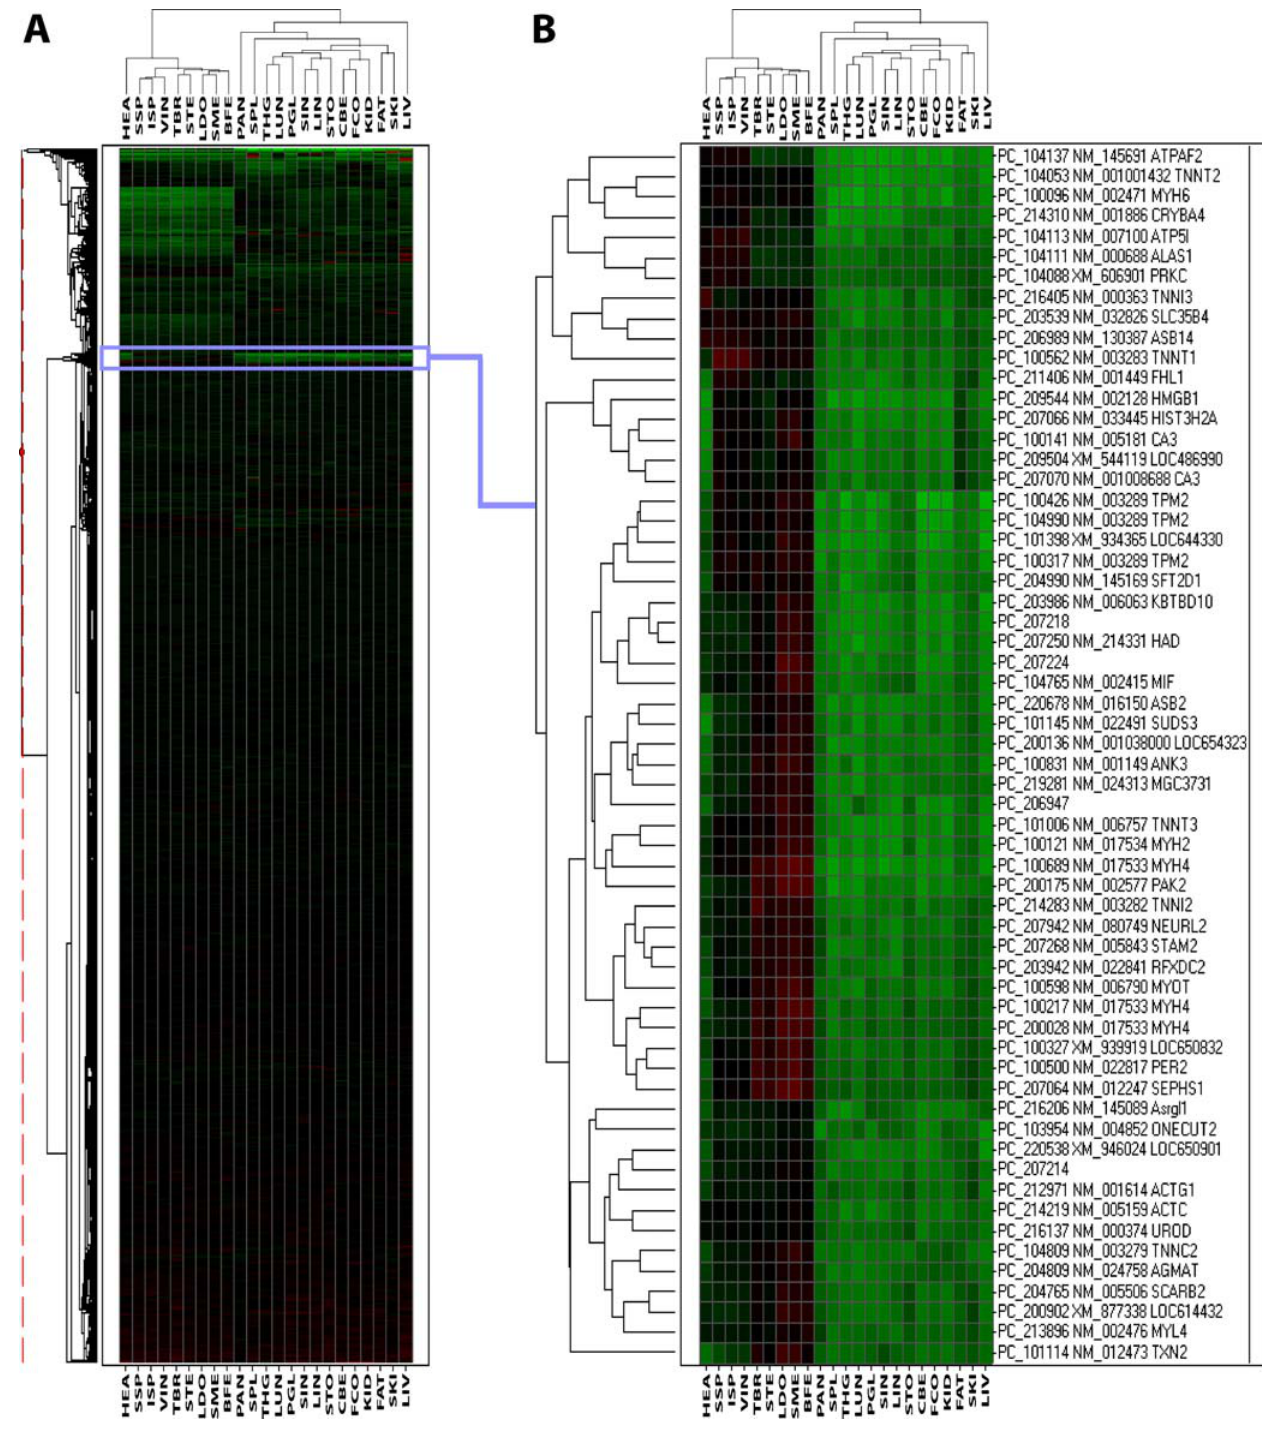
Figure 3. Two-way hierarchical clustering of gene expression ratios. Heatmaps displays the log2(M) on a color scale from green indicating lower expression to red indicating a higher expression, interpolated over black for log2(M)=0. A. Overview of entire hierarchical clustering showing 26.877 cDNAs (row-wise) and 23 tissues (column-wise). B. Enlarged view of selected cDNA cluster. BFE, Biceps femoris; CBE, Cerebellum; FAT, fat; FCO, Frontal cortex; HEA, heart; ISP, Infraspinatus; KID, kidney; LDO, Longissimus dorsi; LIN, large intestine; LIV, liver; LUN, lung; PAN, pancreas; PGL, pituitary gland; SIN, small intestine; SKI, skin; SME, Semimembranosus; SPL, spleen; SSP, Supraspinatus; STE, Semitendinosus; STO, stomach; TBR, Triceps brachii; THG, thyroid gland; VIN, Vastus intermedius.